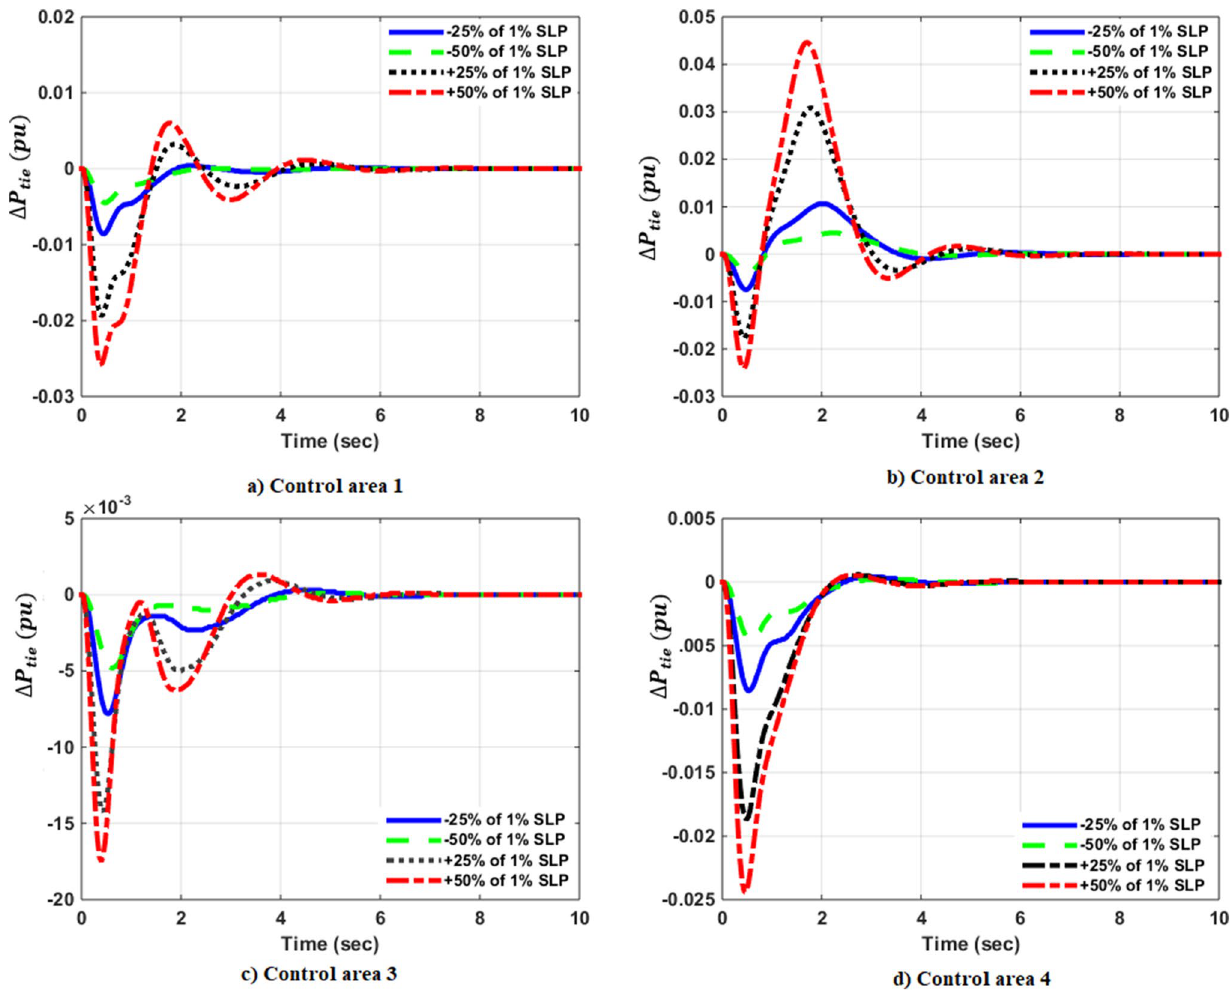
Figure 12. Dynamic responses of Tie-lie power deviations with ( a ) non-reheat turbine, ( b ) reheat turbine, ( c ) hydro turbine, ( d ) gas turbine when changes in % SLP applied at t = 0 sec.